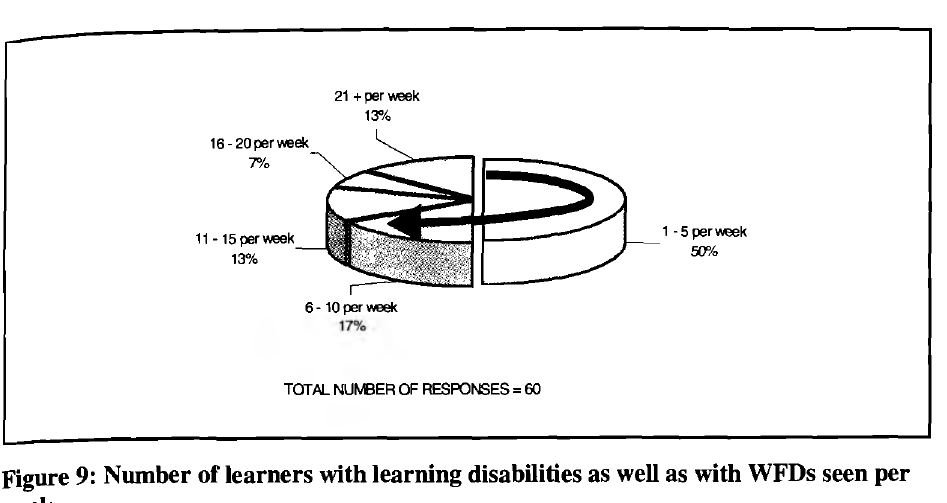
Figure 9: Number of learners with learning disabilities as well as with WFDs seen